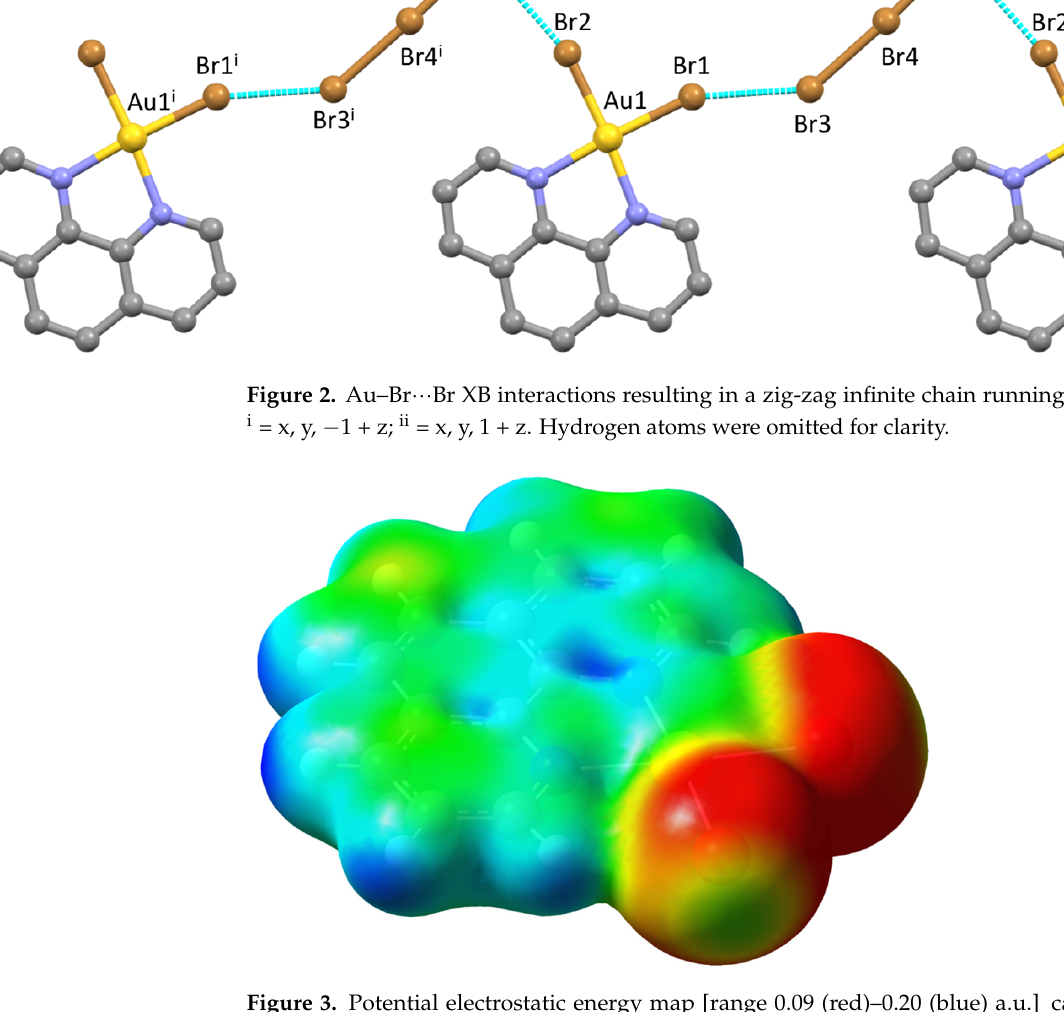
Figure 3. Potential electrostatic energy map [range 0.09 (red)–0.20 (blue) a.u.] calculated for the [Au(phen)Br 2 ] + cation at the DFT level on the density map (electron density = 9.0·10 − 3 |e|/Bohr 3 ).